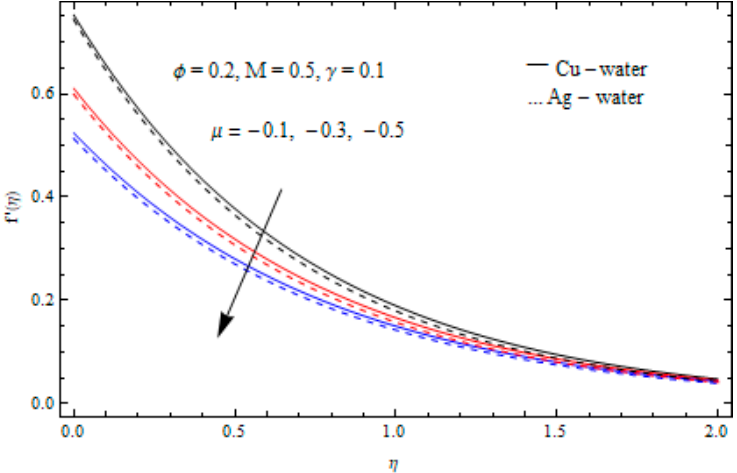
Figure 5. Effect of first slip γ on velocity of SiO 2 -water, Al 2 O 3 -water, and TiO 2 -water nanofluids.